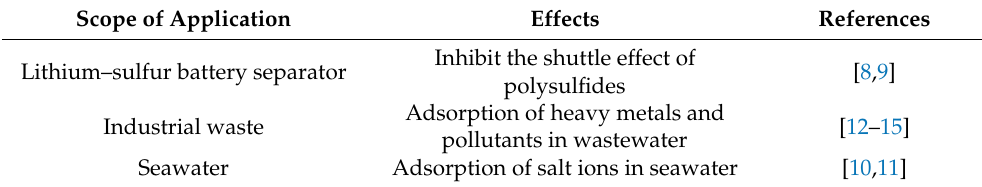
Table 4. Application of MOF